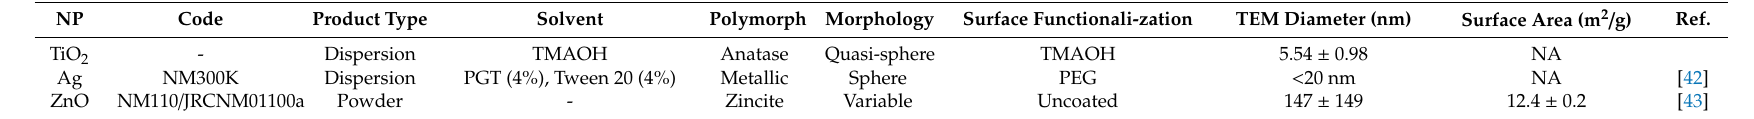
Table 1. Characterization of pristine nanoparticles (NPs). TiO 2 -NPs were provided by ICN2, Ag-NPs by Fraunhofer IME and ZnO-NPs by JRC.